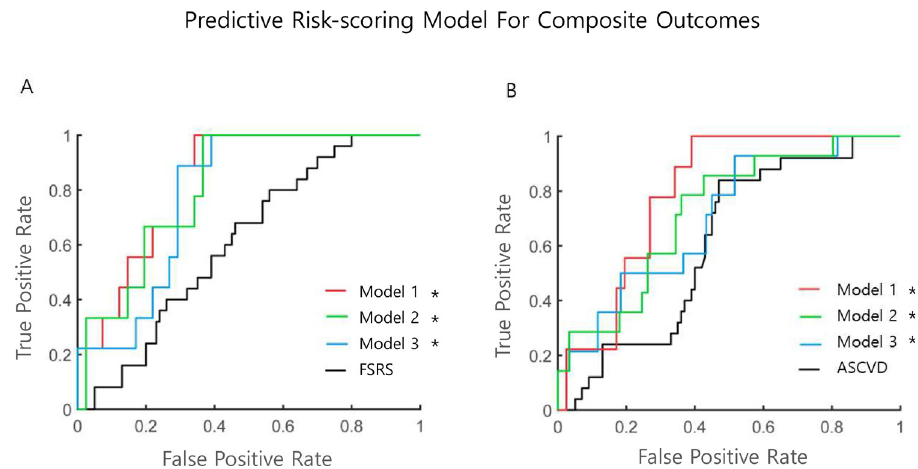
Fig 2. Comparison of ROC curves of novel risk prediction models for composite outcomes. A. Different models based on the FSRS for prediction of composite outcomes. ROC curves in the FSRS (black line), Model 1 (FSRS, PSV ratio, CIMT, high-risk plaque, collateral flow, MFV, and PI, red line), Model 2 (FSRS, PSV/EDV ratio, CIMT, high- risk plaque, collateral flow, MFV, and PI, green line), and Model 3 (FSRS, PSV, CIMT, high-risk plaque, collateral flow, and PI, blue line) are shown. B. Different models based on the ASCVD risk score for prediction of composite outcomes. ROC curves in the ASCVD risk score (black line), Model 1 (ASCVD, PSV, CIMT, high-risk plaque, and PI, red line), Model 2 (ASCVD, PSV/EDV ratio, CIMT, MFV, and PI, green line), and Model 3 (ASCVD, PSV ratio, CIMT, MFV, and PI, blue line) are shown. � indicates statistically significant (p < 0.05) differences relative to classical cardiovascular risk scores (black lines). Abbreviations: ROC, receiver operating characteristics; FSRS, Framingham stroke risk score; PSV, peak-systolic velocity; CIMT, common carotid artery intima-media thickness; MFV, mean flow velocity; PI, pulsatility index; PSV/EDV ratio, peak-systolic-and-end-diastolic-velocity ratio; ASCVD, atherosclerotic cardiovascular